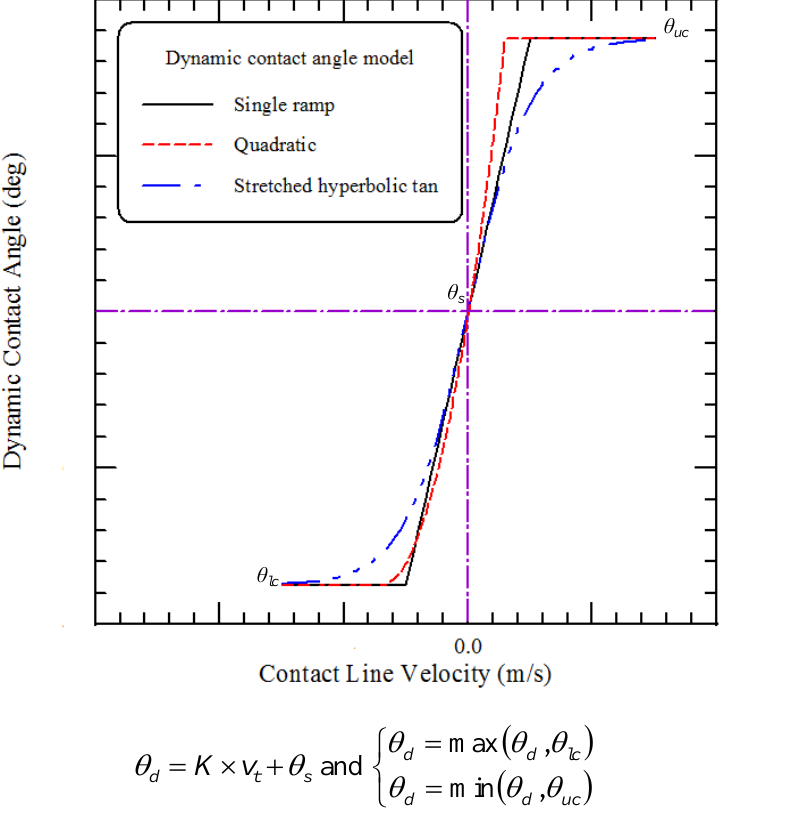
Figure 1. The slope-intercept form and the relationship between the contact angle and the contact line velocity.